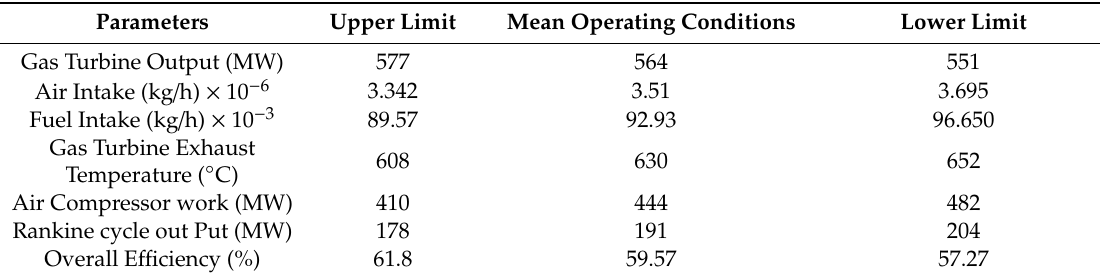
Table 1. Expected full load operating conditions range to confine the simulation errors and variations in real operating conditions.